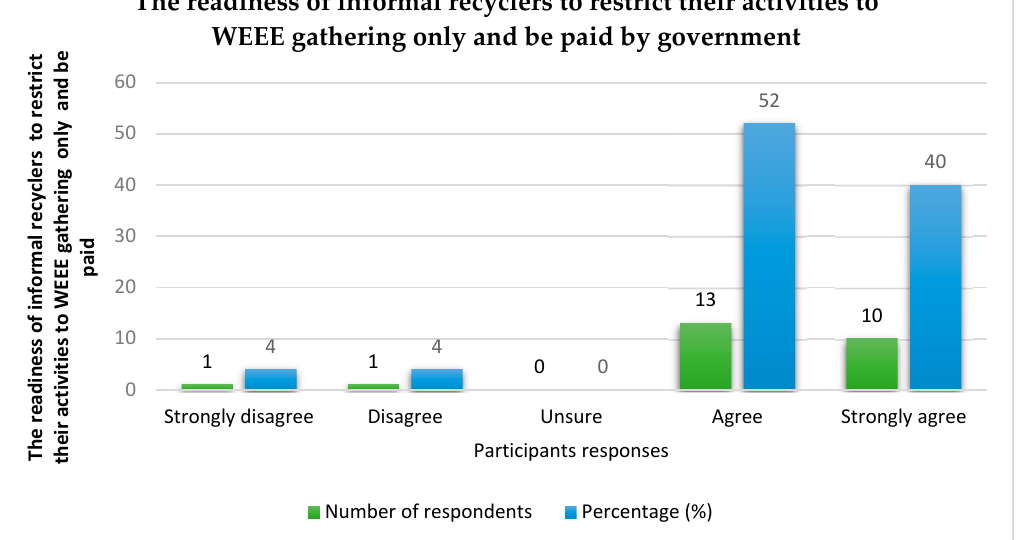
Figure 5. A plot of the readiness of informal recyclers to restrict their activities to WEEE gathering only and be paid.